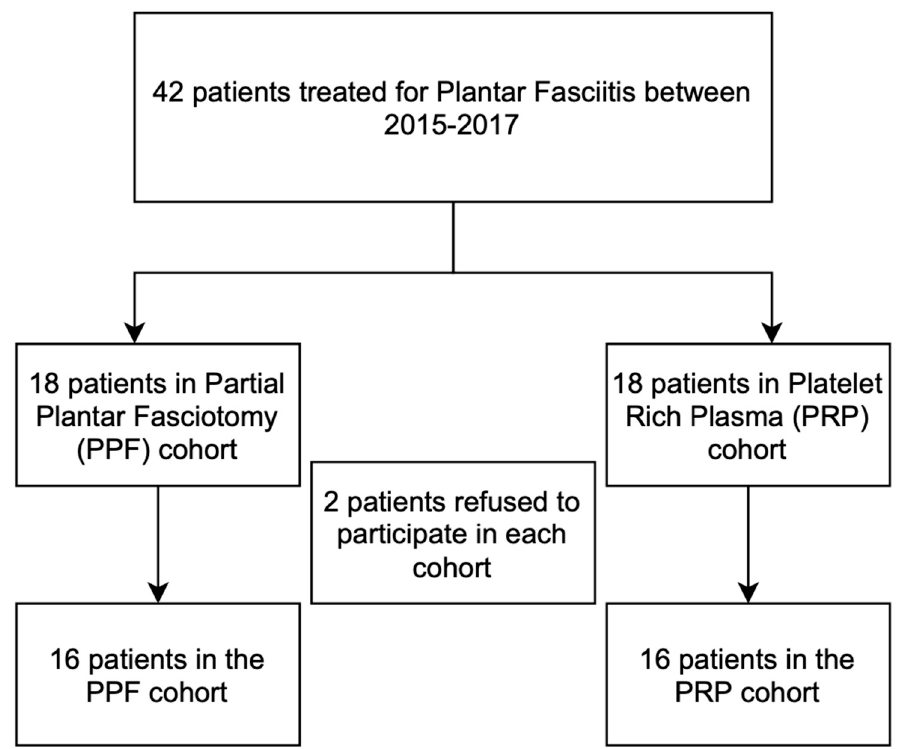
Figure 3. P atient selection process.